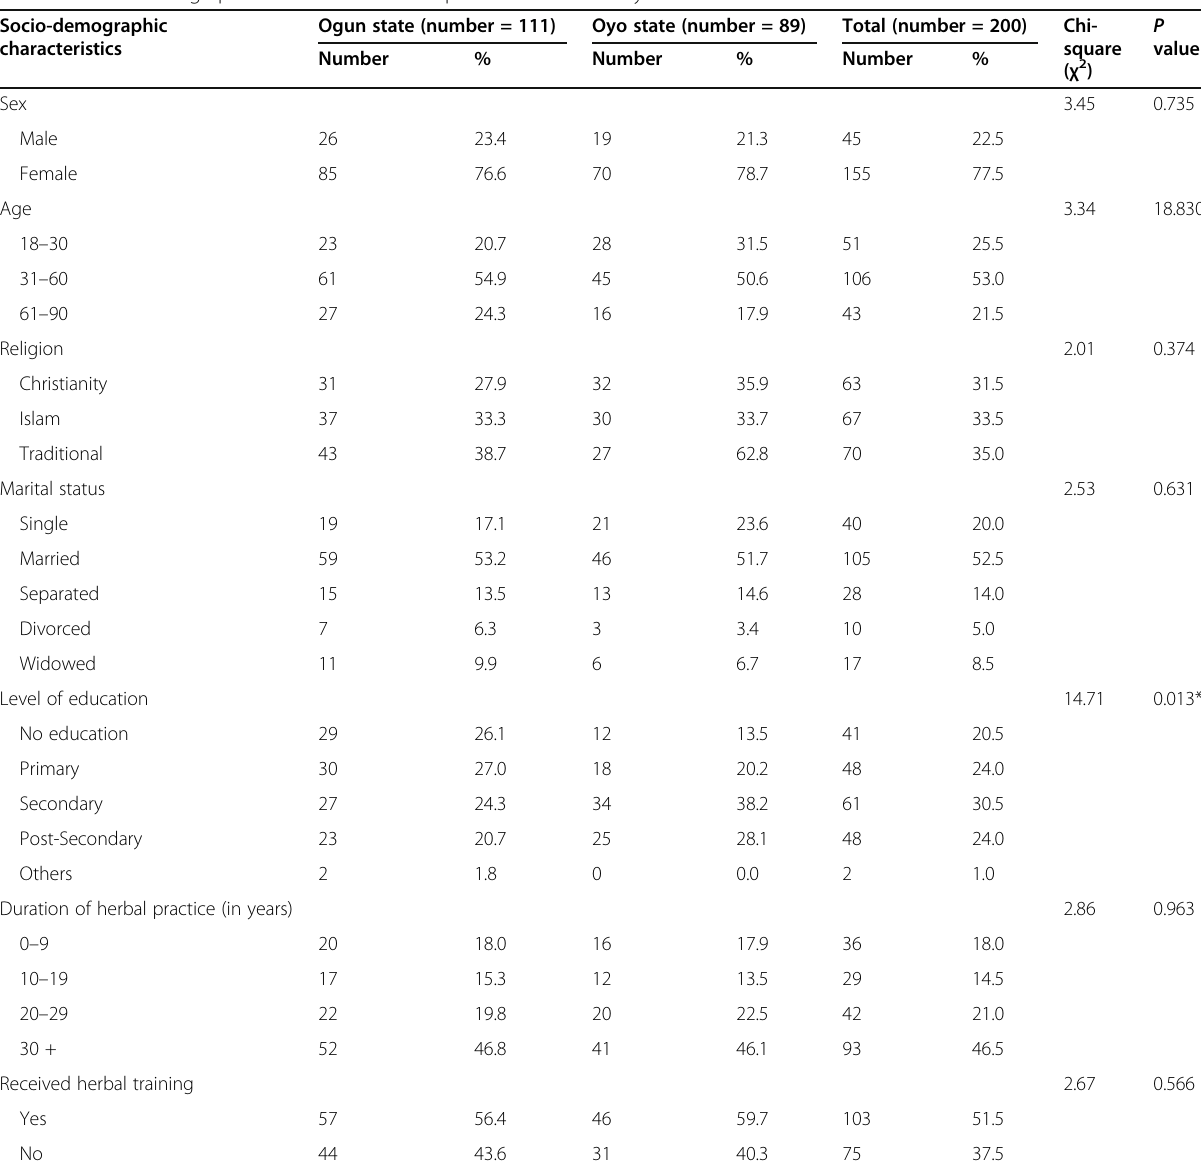
Table 1 Socio-demographic characteristics of respondents from survey areas Socio-demographic